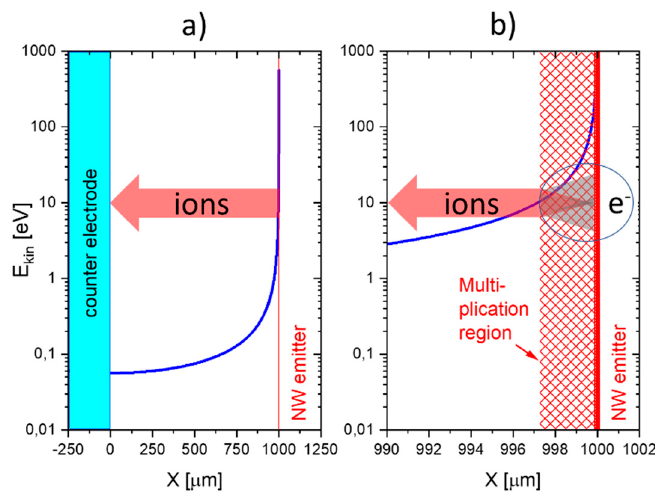
Figure 17. ( a ) Kinetic energy gained in between gas-kinetic collisions inside the electrode gap of an E-FP device (see Figure 11). The red arrow indicates the flow of positive ions toward the cold collector electrode through the low-field region where ions suffer gas-kinetic collisions but are unable to form secondary ion-electron pairs; ( b ) detailed view onto the air space immediately adjacent to the positive nanowire (NW) emitter. Inside this region, secondary ion-electron pairs are created, leading to a huge enhancement of the primary SI current.